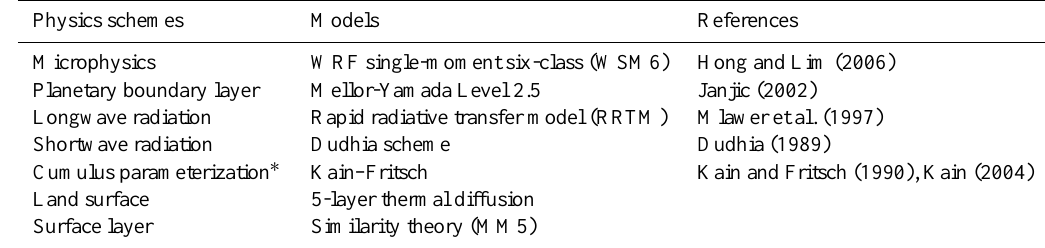
Table 1. WRF physics parameterization schemes used in the study.